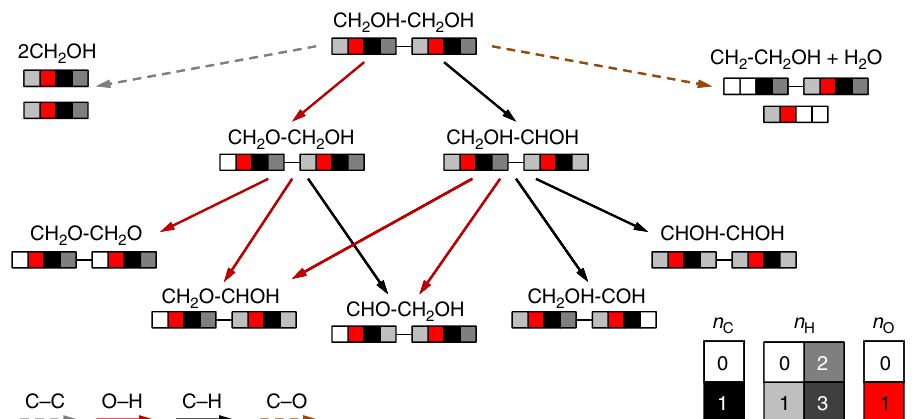
Fig. 2 Reaction network for the decomposition of ethylene glycol. Each CH x OH moiety is shown as a quadruplet whose colors are representative of the stoichiometry. The two central boxes are red (O) and black (C) while the fi rst and last boxes indicate the number of hydrogen atoms attached to them, darker gray stands for higher H content. C – C, O – H, C – H, and C – O bond breakings are displayed as gray, red, black, and brown arrows respectively. C – C breakings lead to the lateral path of methanol decomposition, while C – O breakings lead to the lateral path of ethanol and water dehydrogenation. The full set of reactions is shown in Supplementary Figs. 14 – 16